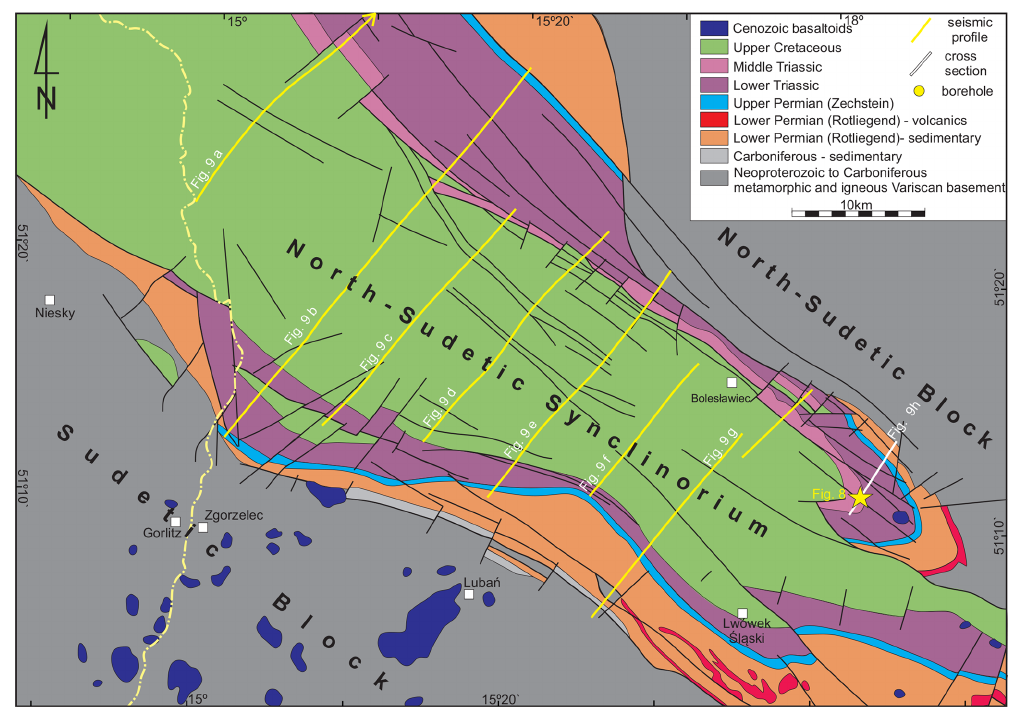
Figure 6. Geological map (without Cenozoic) of the North Sudetic Synclinorium (based on Bałazi´nska and Bossowski, 1979; Solecki, 1994; Krentz et al., 2000; Cymerman, 2010), showing locations of the interpreted seismic profiles. For full-length location of the seismic profile of Fig. 9a, see Fig.